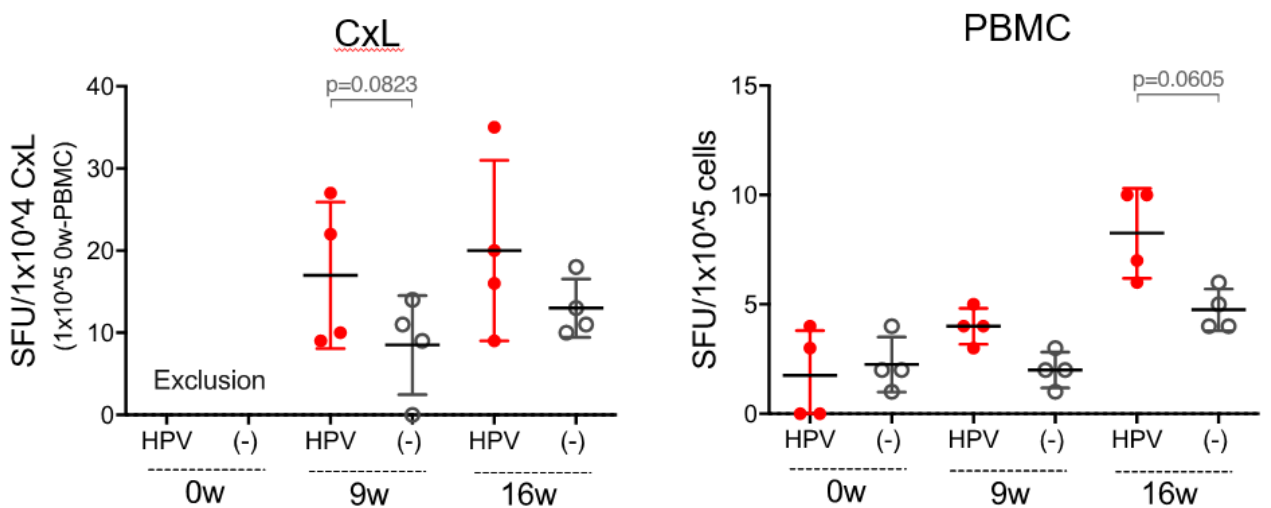
Figure 2. Time-dependent increases in the number of IFN γ -producing cells in the GLBL101c group. The number of IFN γ -producing cells at pre-immune (0 week), 9week, and 16week was compared for CxL and PBMC with (red dot) and without (circle dot) E7 stimulation. The number of spots with E7 stimulation (HPV+) tended to increase in a time-dependent manner, with three samples showing a similar increase.